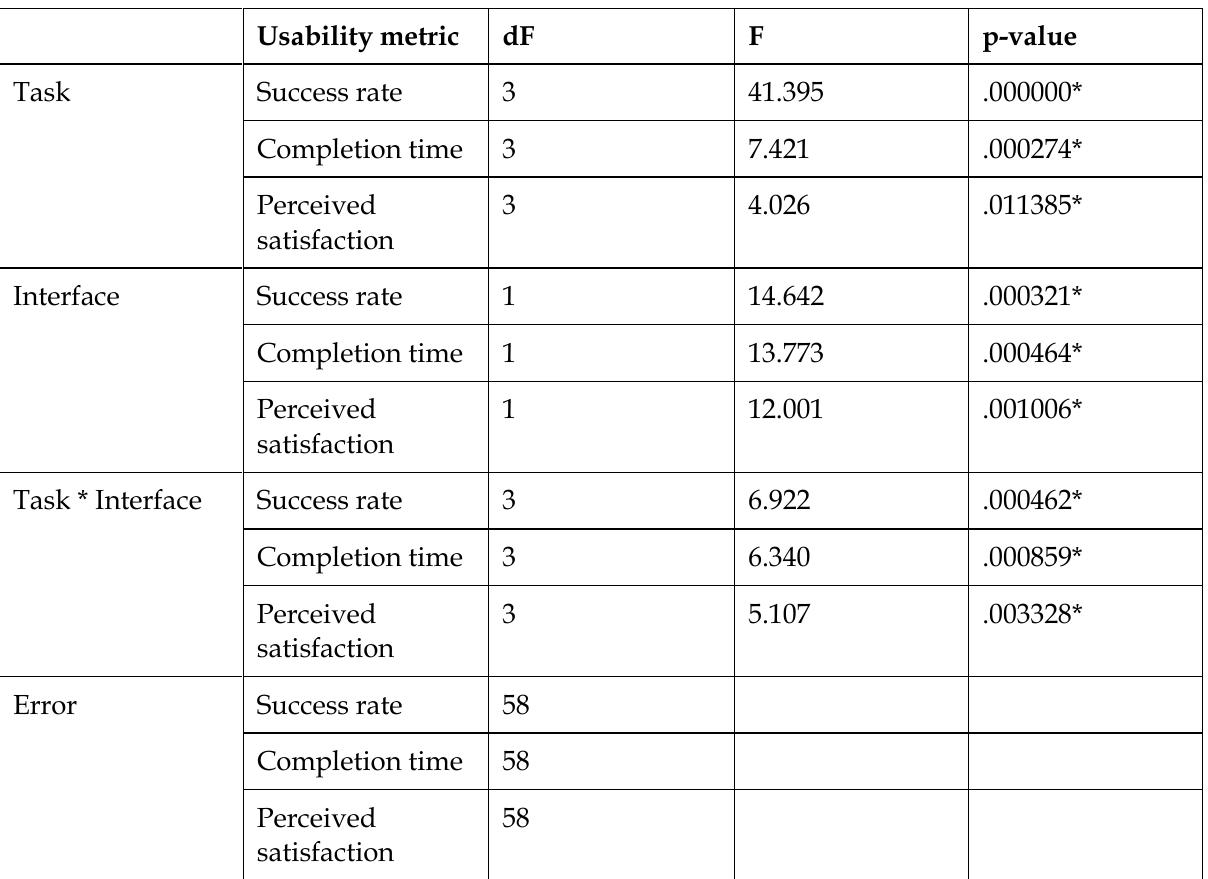
Table 2: p-values when applying the two-way repeated measures ANOVA. Null hypothesis: the median of success rate, completion time and perceived satisfaction of the two interfaces (A: including a tree map versus B: including a stacked ba chart) are equal